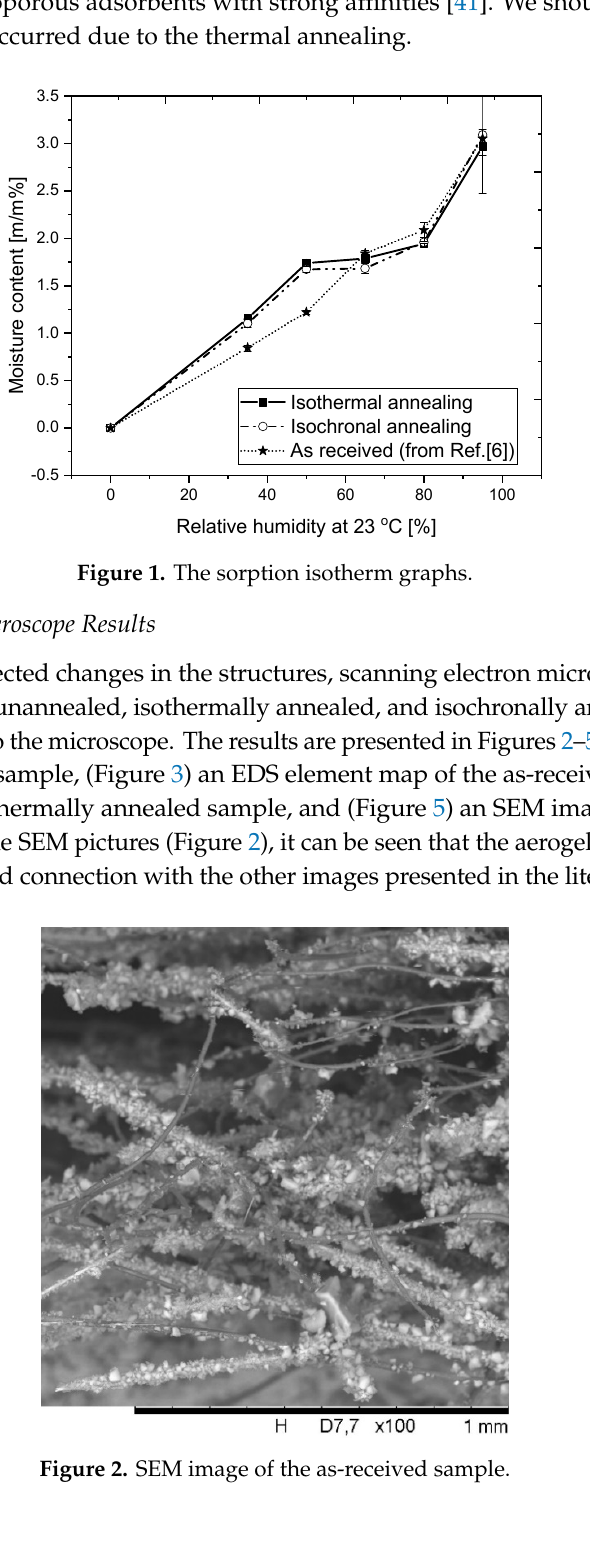
Figure 2. SEM image of the as-received sample.